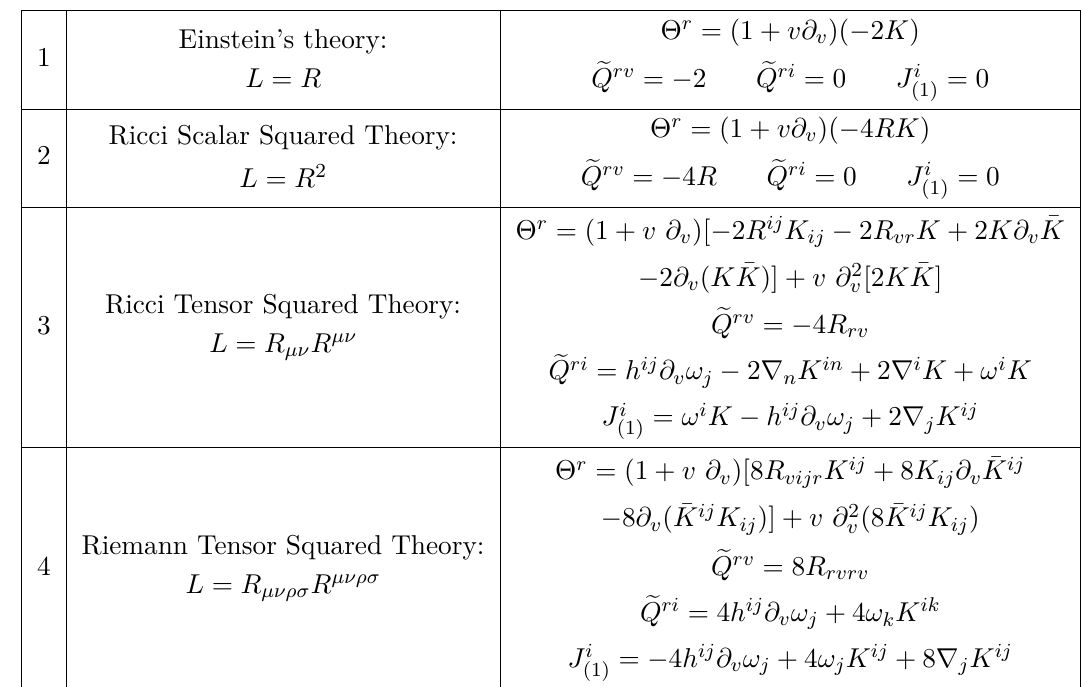
Table 6 . Summary of the various quantities needed to compute the Entropy currents.